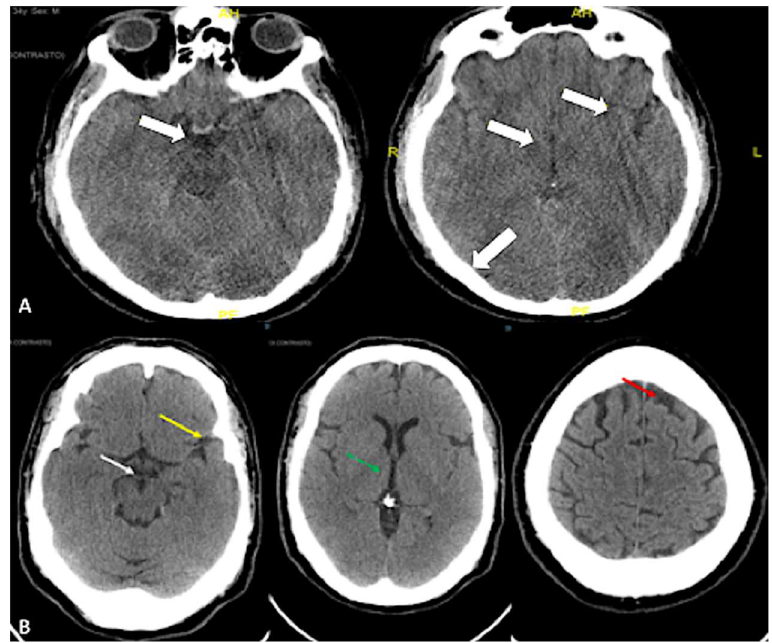
Figure 2. ( A ) The axial computed tomography (CT) scans evidence diffuse edema with cortical sulci, Sylvian fissure, third ventricle, and perimesencephalic cistern compressed but still visible. White arrow on the left scan shows the perimesencephalic cisterns, while white arrows on the right scan show the cortical sulci, third ventricle, and Sylvian fissure from left to right, respectively. ( B ) CT scan of a control case. The cortical sulci (red arrow), the perimesencephalic cisterns (white arrow), the Sylvian fissure (yellow arrow), and third ventricle (green arrow with dotted line) are clearly visible. No radiological sign of edema is evidenced.